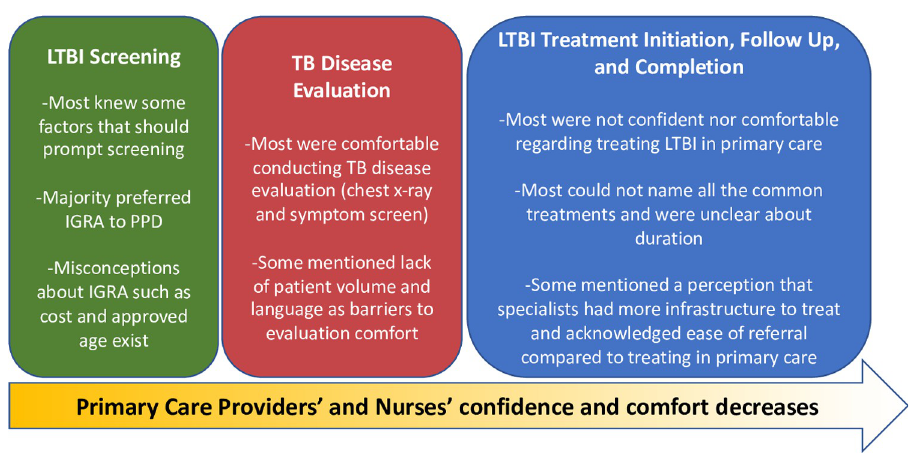
Fig 1. Primary care providers’ and nurses’ knowledge, attitudes, and skills regarding LTBI management–major themes throughout the care